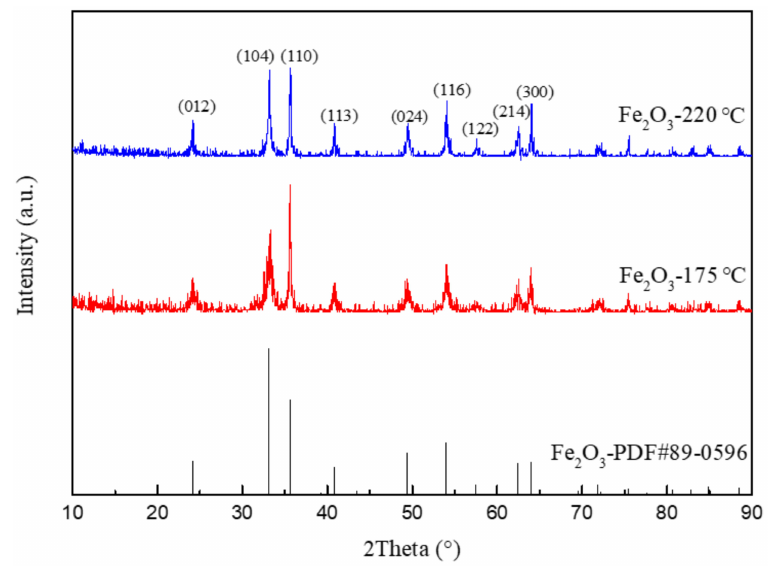
Figure 3. XRD patterns of Fe 2 O 3 prepared at 220 ◦ C and 175 ◦